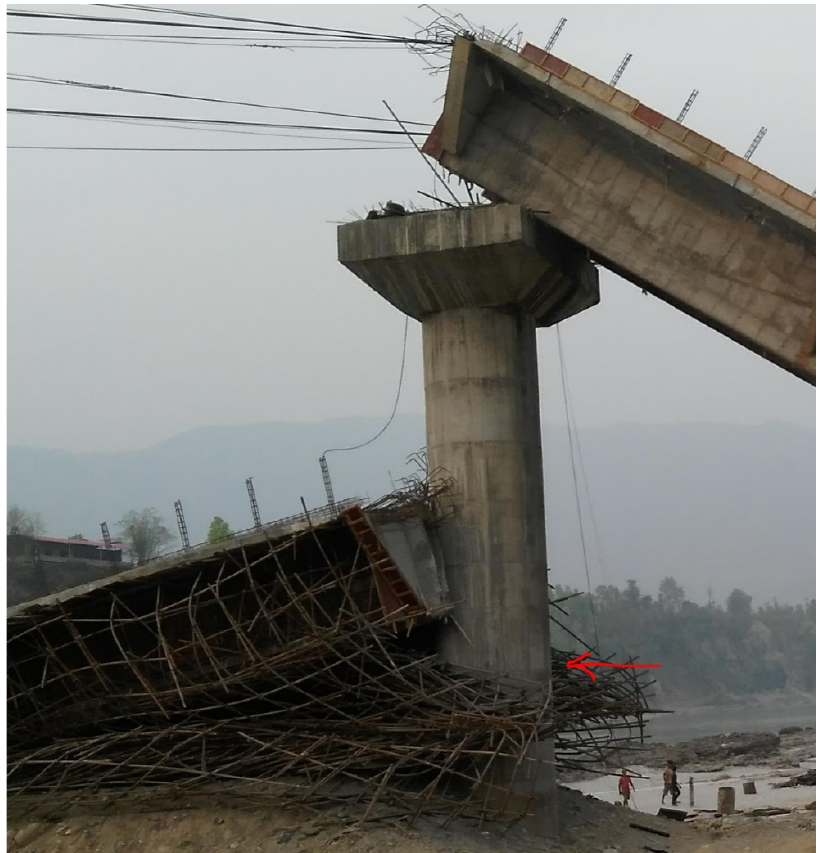
Figure 20. Pier-1 being pushed by Span-1 from the top and Span-2 from the middle in opposite directions. Horizontal crack is marked with an arrow.